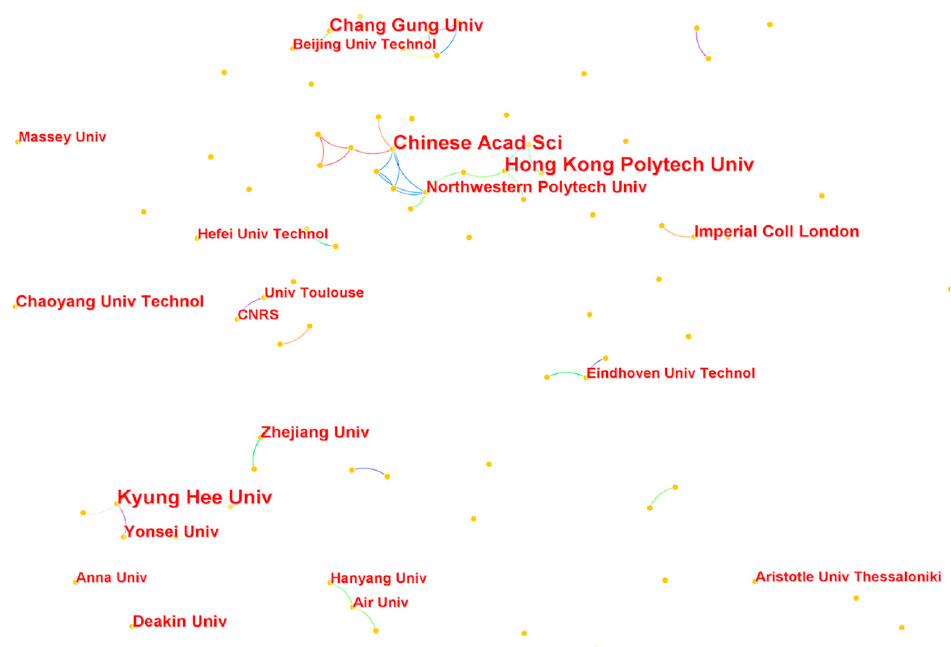
Figure 6. The institution network of studies from WOS. Table 7. Top 10 institutions for publications from WOS.